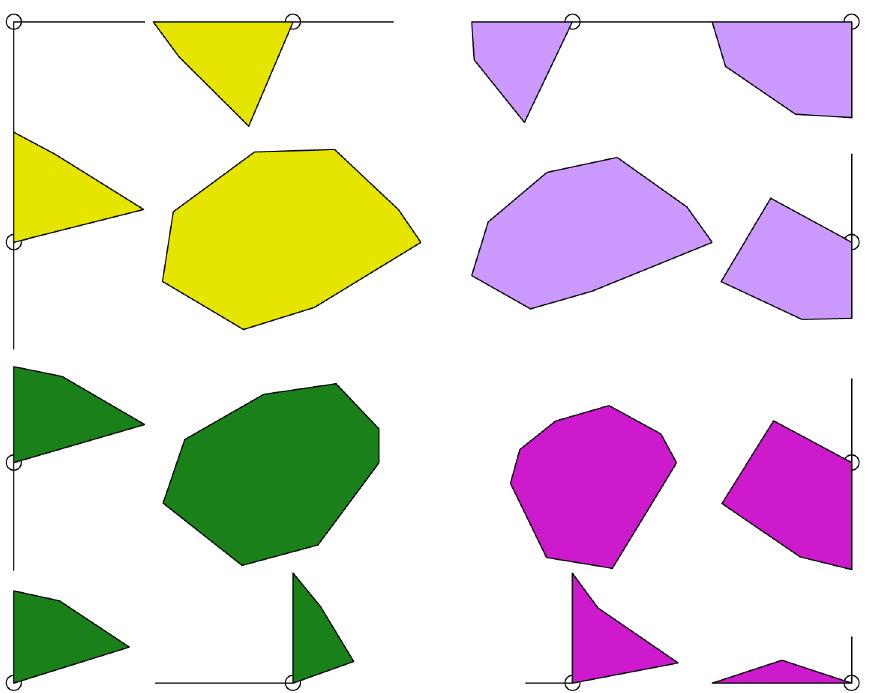
Fig 4. Representation of the distances in the Kohonen map. The gaps coincide with the fontiers of the macro-classes (colored).